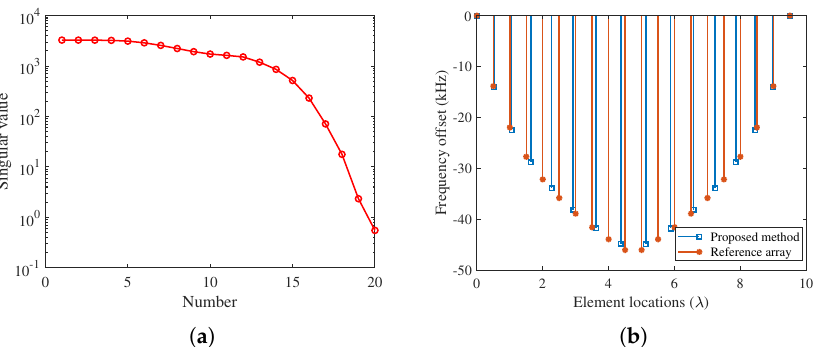
Figure 3. The eigenvalue spectrum and the distribution of frequency offsets and element positions.